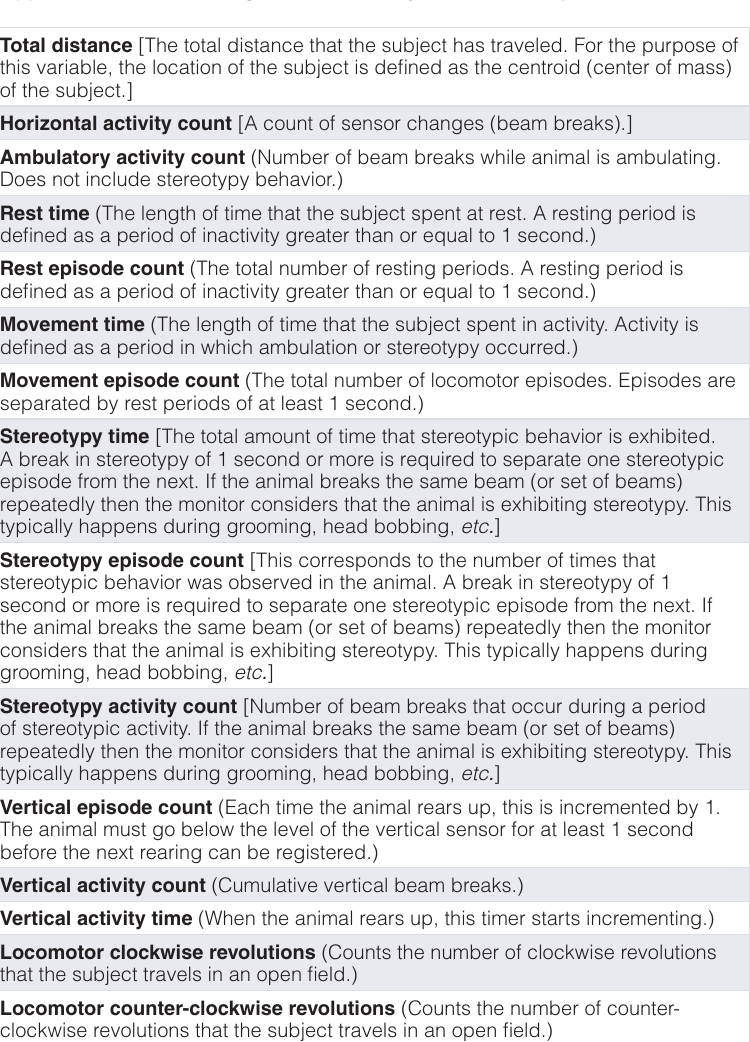
Supplemental Table II b. Legend for �oluntary locomotion dependent